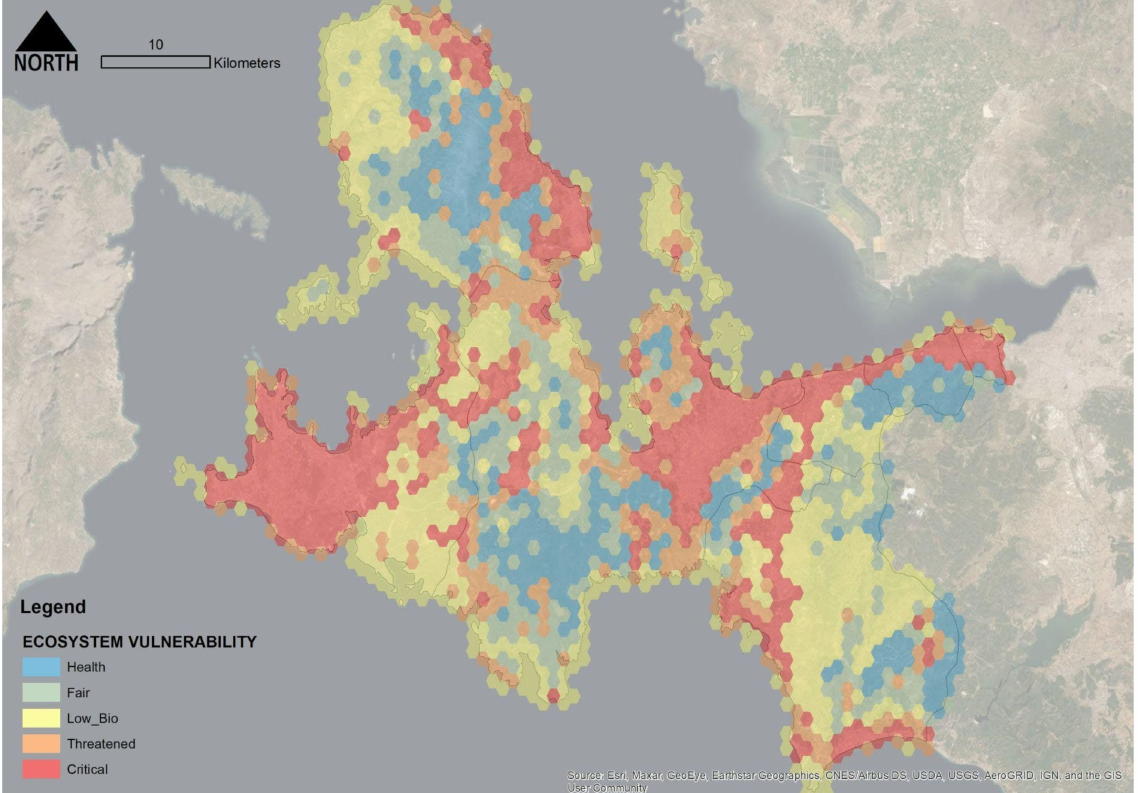
Figure 8. Habitat Vulnerability